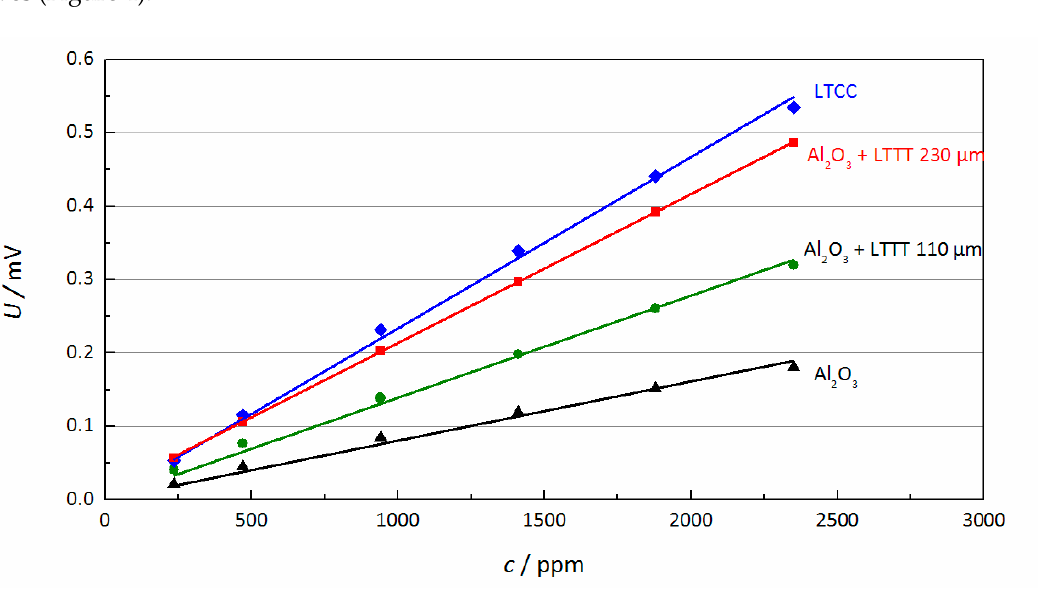
Figure 4. Comparison of sensor sensitivity to propane for different substrates/materials